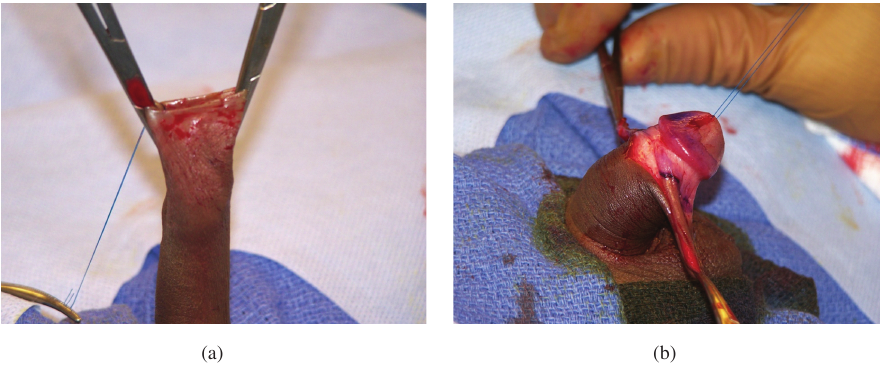
FIGURE 5: (a) The dorsal-ventral slit technique of circumcision involves making these incisions and then (b) removal of the skin between them. Sutures are most commonly used to approximate the skin